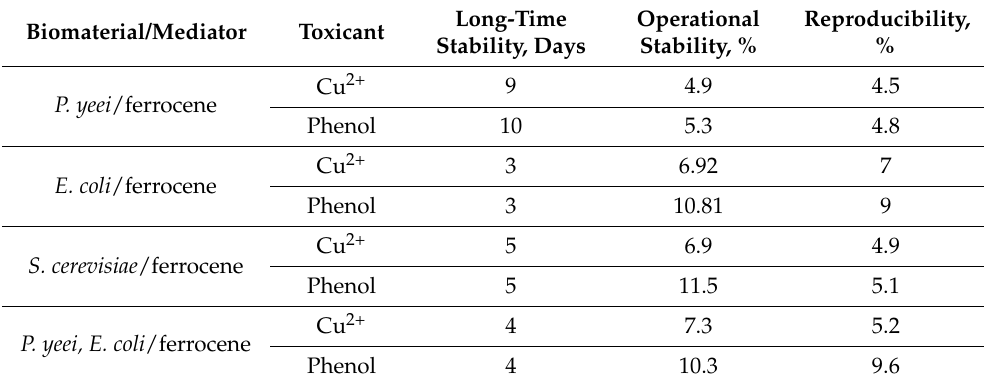
Table 6. Analytical characteristics of the developed systems.